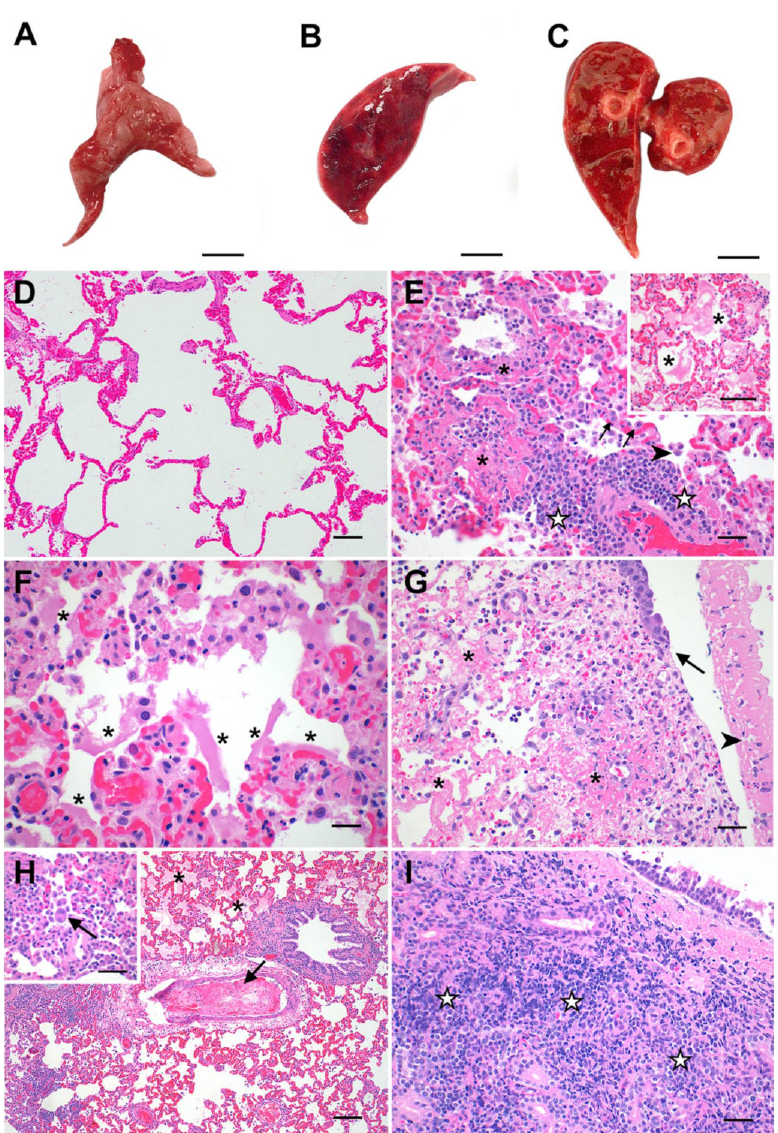
Figure 2. Pathologic features of acute SARS-CoV-2 infection in cats are analogous to the exudative phase of COVID- 19. Compared to lungs from healthy sham-inoculated cats ( A ), the lungs of SARS-CoV-2-infected cats were diffusely consolidated, dark red, and edematous at both 4 dpi ( B ) and 8 dpi ( C ). The lungs of healthy, uninfected cats ( D ) were histo-